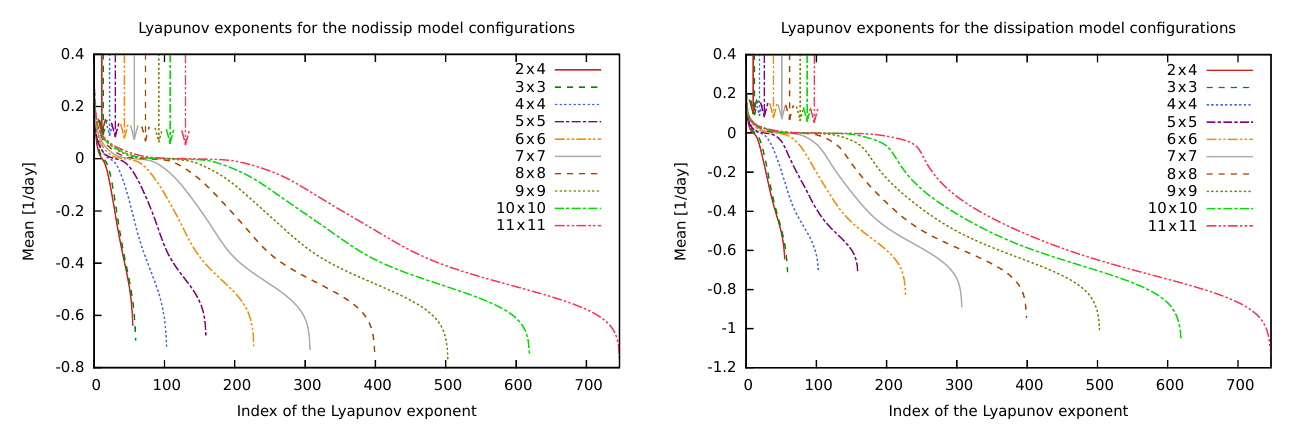
Figure 13. Lyapunov spectra of MAOOAM for the “dissipation” experiment. Colours and arrows as in Fig. 11.